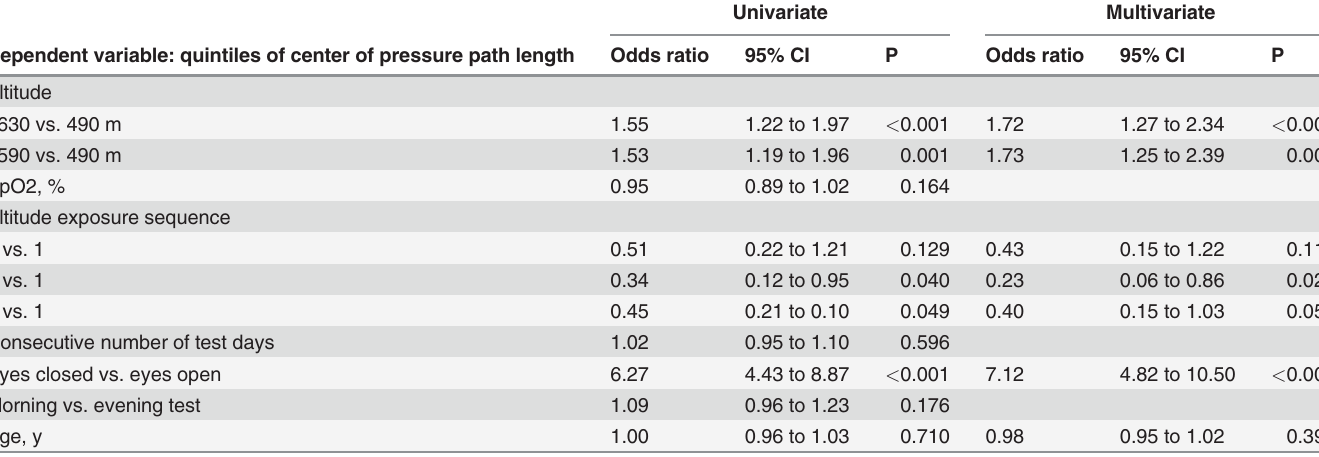
Table 4. Effect of altitude on center of pressure path length: ordinal logistic regression analysis.